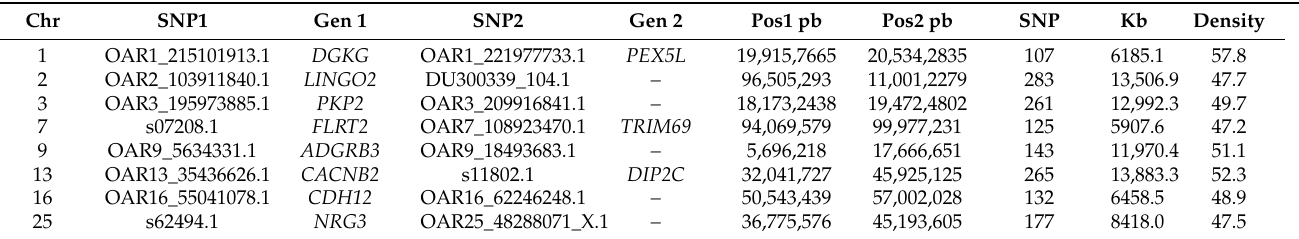
Table 5. Genomic regions and genes identified to be associated with prolificacy in sheep.